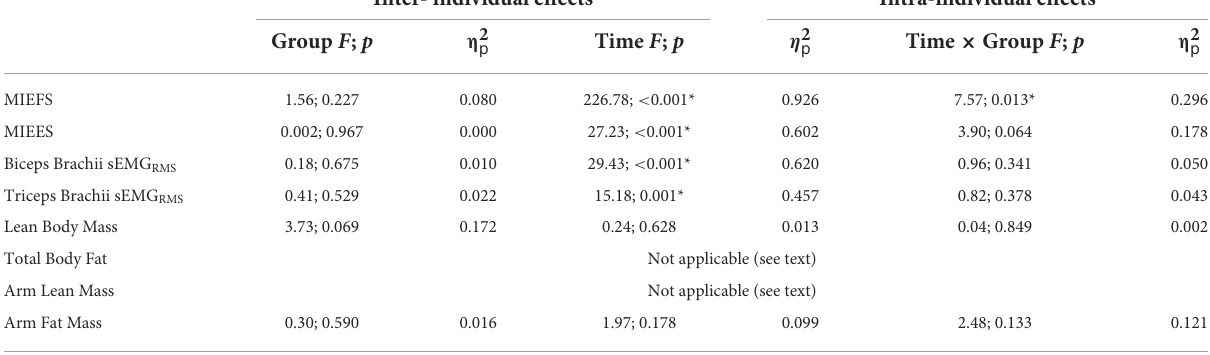
TABLE 2 Result of the 2 × 2-ANOVAs (inter- and intra-individual